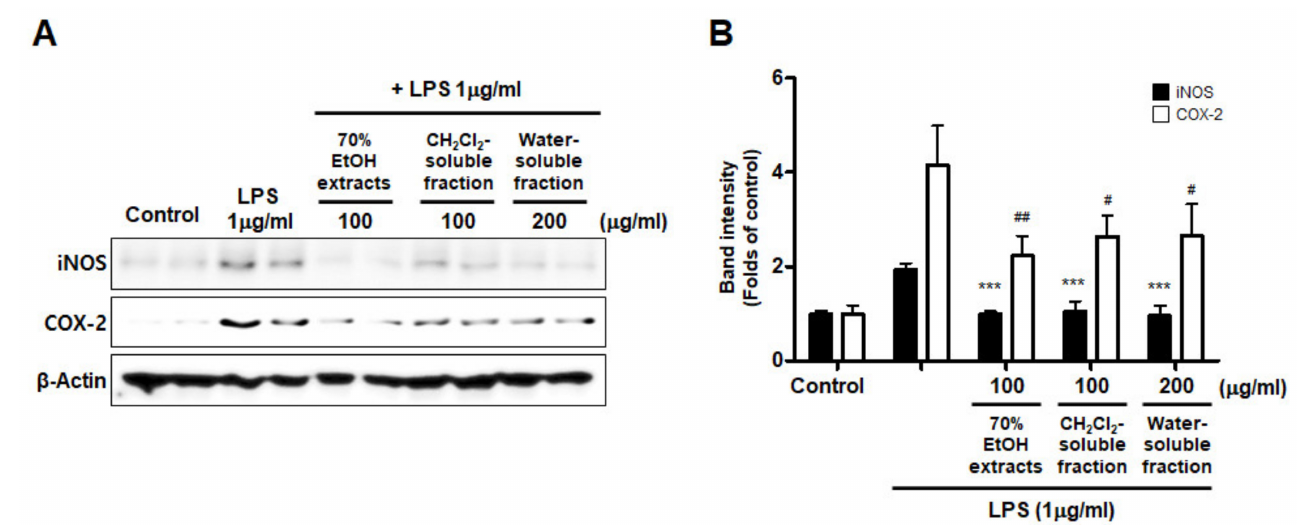
Figure 8. Effects of 70% EtOH extract and its CH 2 Cl 2 - and water-soluble fractions on iNOS and COX-2 protein levels in BV2 cells. ( A ) Cells were treated with the indicated concentrations of 70% EtOH extract and its CH 2 Cl 2 - and water-soluble fractions for 3 h, and then stimulated for 24 h with LPS (1 µ g/mL). The method used to perform the Western blot analysis is described in detail in the Materials and Methods section. ( B ) Immunoblots were quantified using ImageJ software. Band intensity was normalized to β -actin. *** p < 0.001, # p < 0.05, ## p < 0.01, compared to LPS-treated group. Control means an untreated control